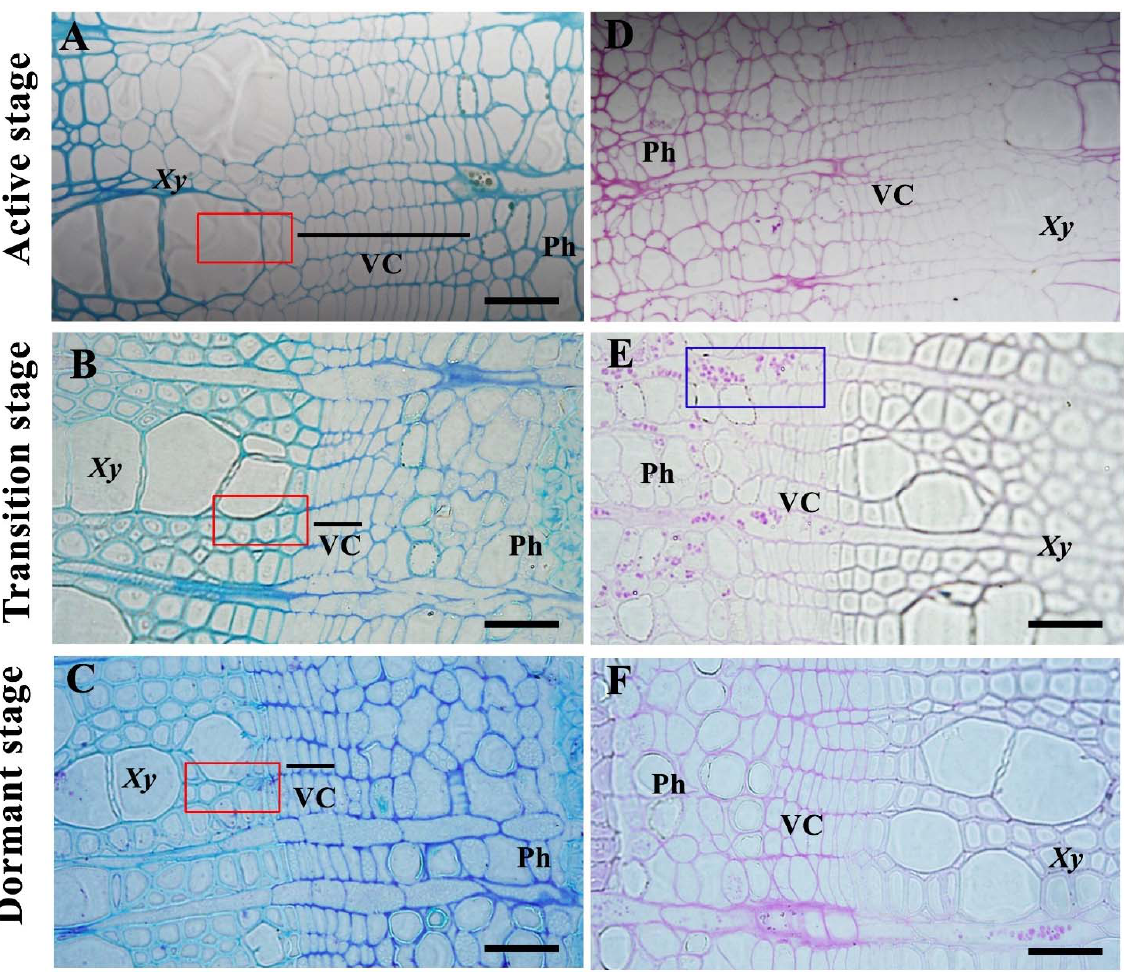
Figure 1. Morphology observation and polysaccharide analysis in the cambium of P. tomentosa . ( A – C ) active, transition, and dormant cambium stages. ( D – F ) distribution of polysaccharides in cambium and phloem at the three stages. Scale bars: 100 µ m. The red boxes show the developing xylem outside of the cambium and the blue box show the polysaccharides. Xy, Xylem; Ph, Phloem; VC, Vascular